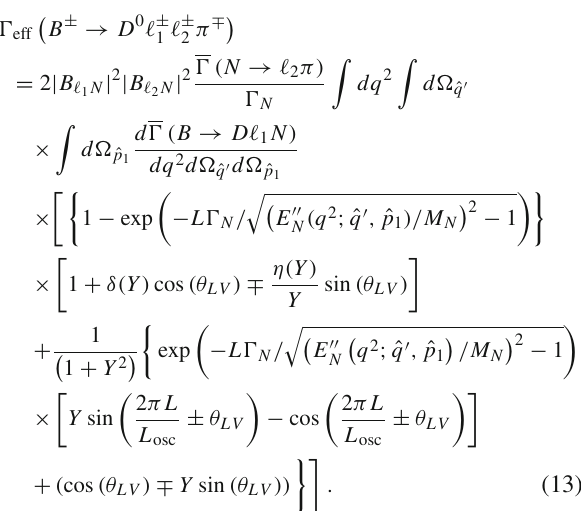
(cid:9) = (cid:9) N 2 N . This is because the total decay width of the heavy neutrino N j is